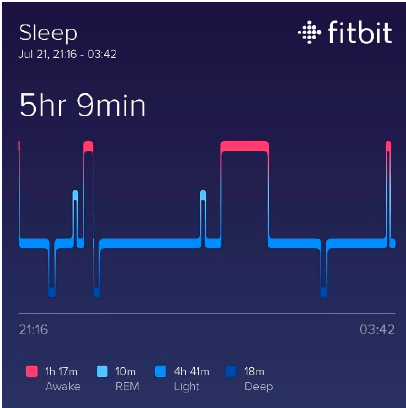
Figure A27. Bangkok,